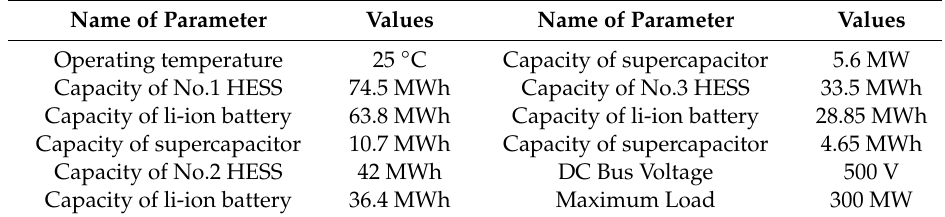
Table 2. Main parameters of the simulation